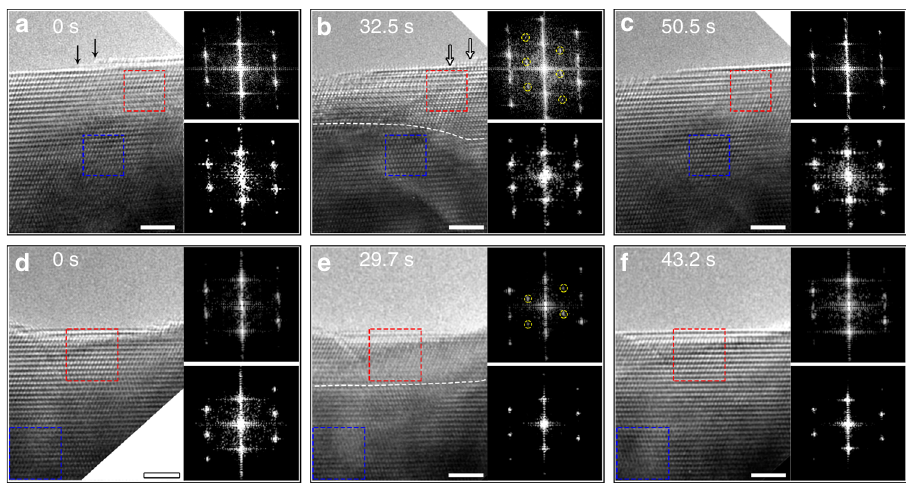
Fig. 2 Structural oscillations in CuO lattice with different surface morphologies. a – c Time-resolved HRTEM images (Supplementary Movie 2) of the CuO lattice upon exposure to a continuous fl ow of hydrogen gas at T ≈ 300 °C and pH 2 ≈ 0.5 Pa, where the retraction motion of surface steps is monitored. Dark and white arrows in a , b mark the location of surface steps at 0 s and 32.5 s, respectively. d – f Time-resolved HRTEM images (Supplementary Movie 3) of the CuO lattice at T ≈ 300 °C and pH 2 ≈ 0.5 Pa, where the majority of the surface is nearly atomically fl at. Diffractograms on the upper- and lower-right side are extracted from the subsurface and deeper bulk regions as marked by the red and blue dashed boxes, respectively, in each HRTEM image. Superlattice diffraction spots are indicated by yellow dashed circles. The white dashed lines in b , e mark approximately the boundary between the superlattice region and the deeper, unaffected region. Scale bar, 2